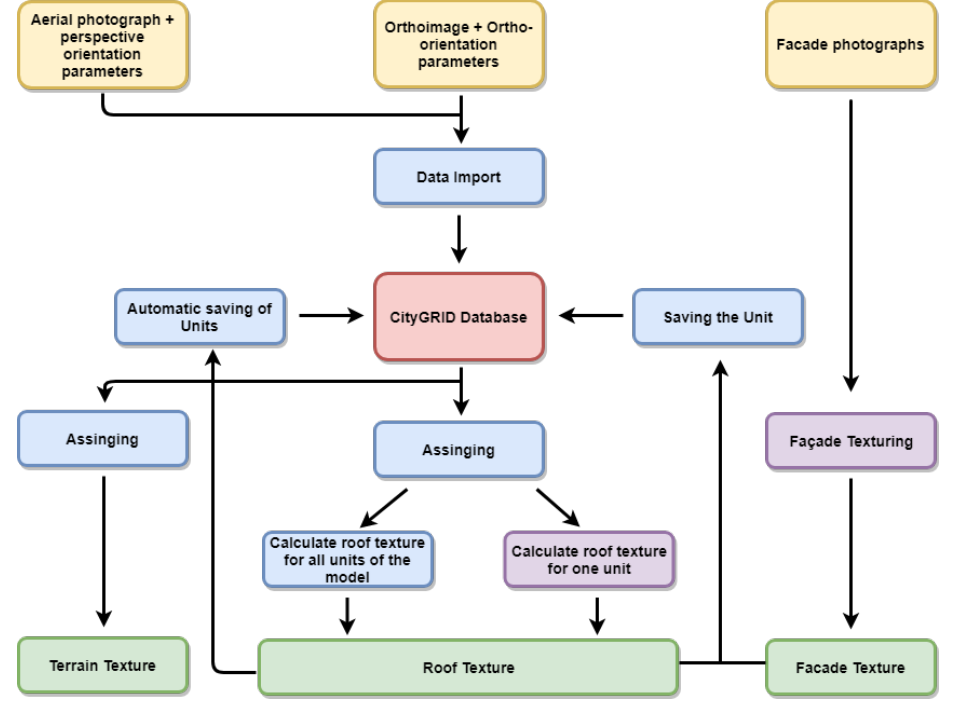
Figure 16. CityGRID Texturizer automatic texturing workflow [ 39 ].